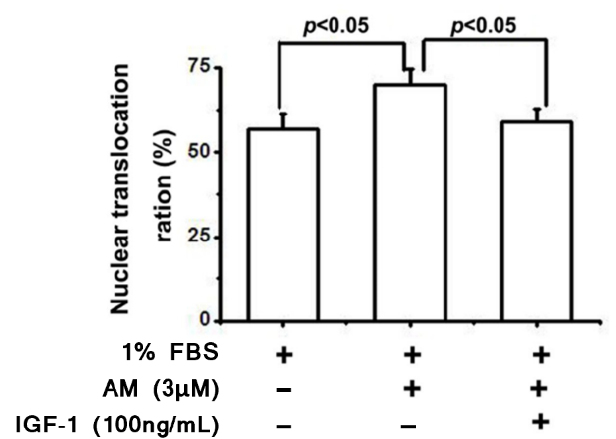
Figure 8. Amiodarone increases nuclear translocation of FoxO3a in RGCs, leading to increased apoptosis. IGF-1 significantly attenuates this process in amiodarone-treated RGCs. Fluorescence microscopy was utilized to identify cytosolic or nuclear localization of FoxO3a, and the nuclear translocation ration was calculated as the percentage of RGCs with nuclear predominance of FoxO3a compared to all cells that could be classified as either nuclear or cytosol predominant [40].